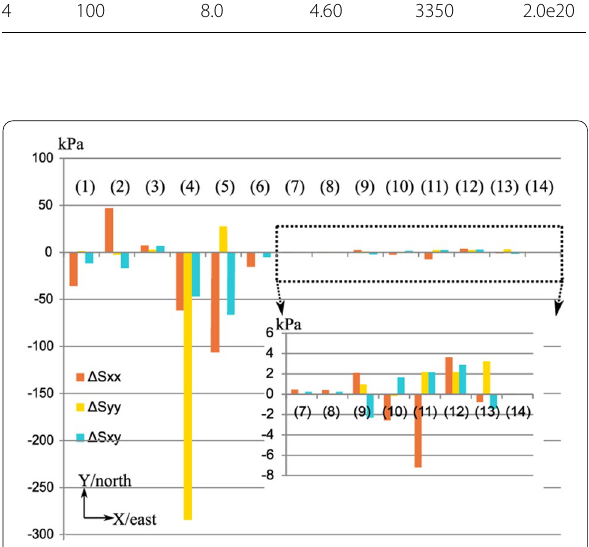
Fig. 2 The combined stress change in three components caused by 14 historical earthquakes at the hypocenter of 2021 earthquake (depth 10 km). Numbers (1)–(14) represent the 14 events, = respectively, same as Table 1